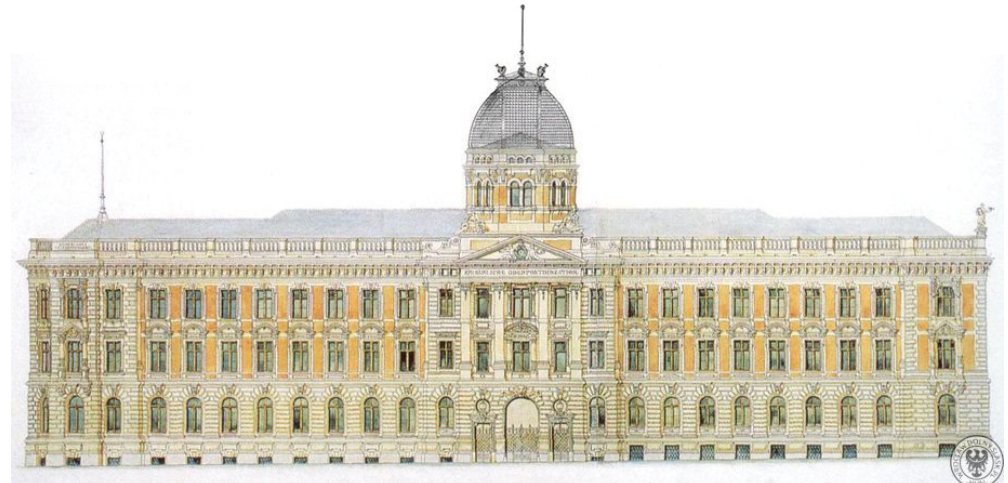
Figure 10. Design of the façade of the Imperial Main Post Office by Walter Kyllmann, Adolph Heyden, and Carl Doflein in Breslau, Germany, 1884–1888 (collections of the building archive in Wrocław (Czechowicz et al. 1997)).